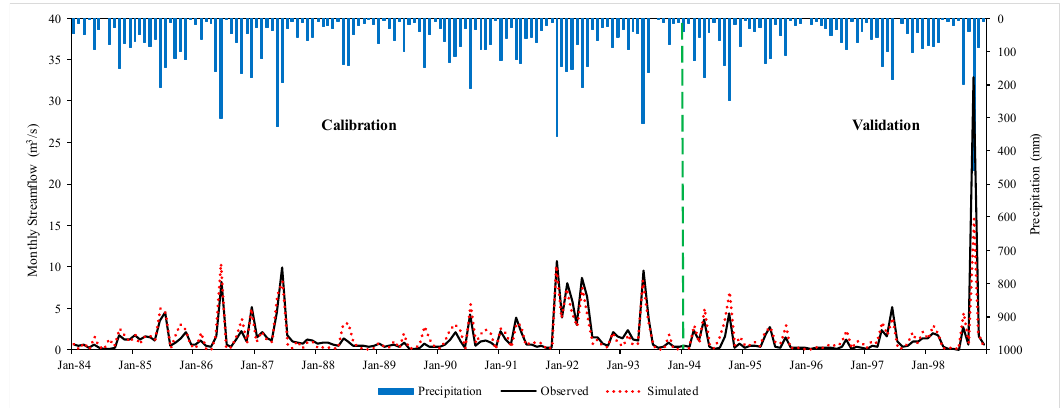
Figure 9. Observed and simulated time series streamflow for the Walzem Creek watershed during calibration and validation periods.